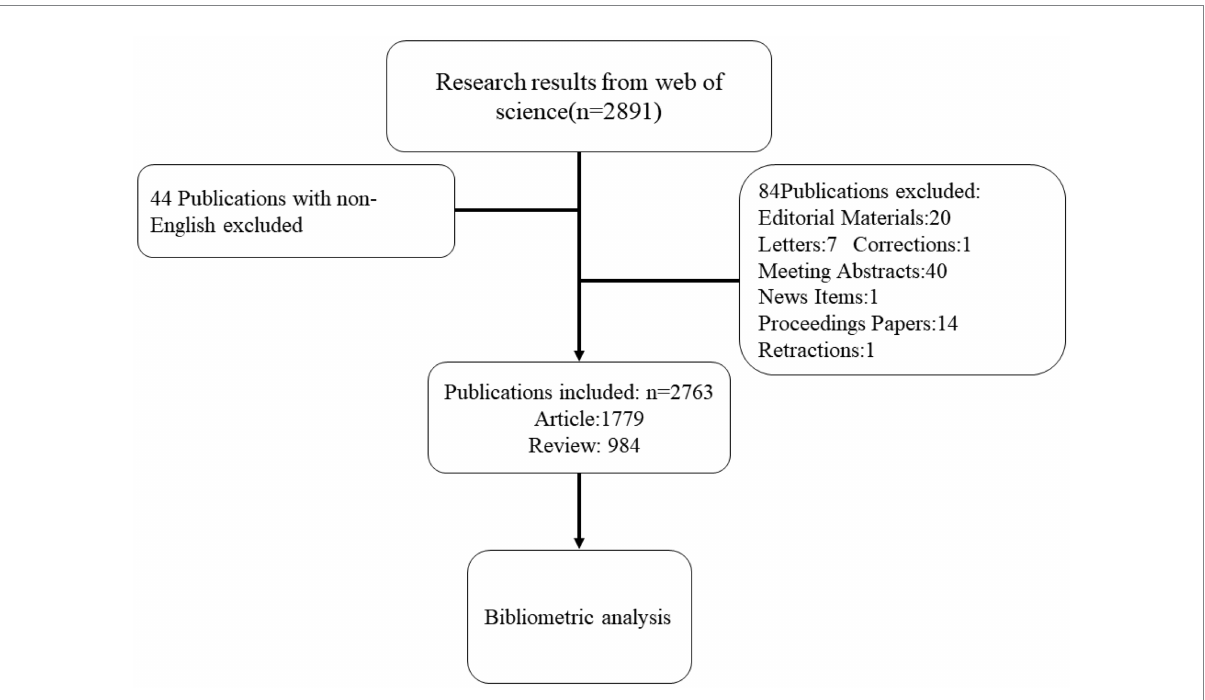
FIGURE 1 Flow chart of the study.